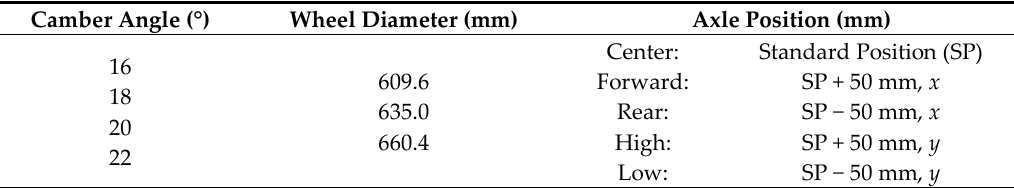
Figure 1. Referred wheelchair model for constructing wheelchair rugby model ( a ); and constructing wheelchair rugby wheelchair model ( b ). Table 2. Setting of each parameter in competition